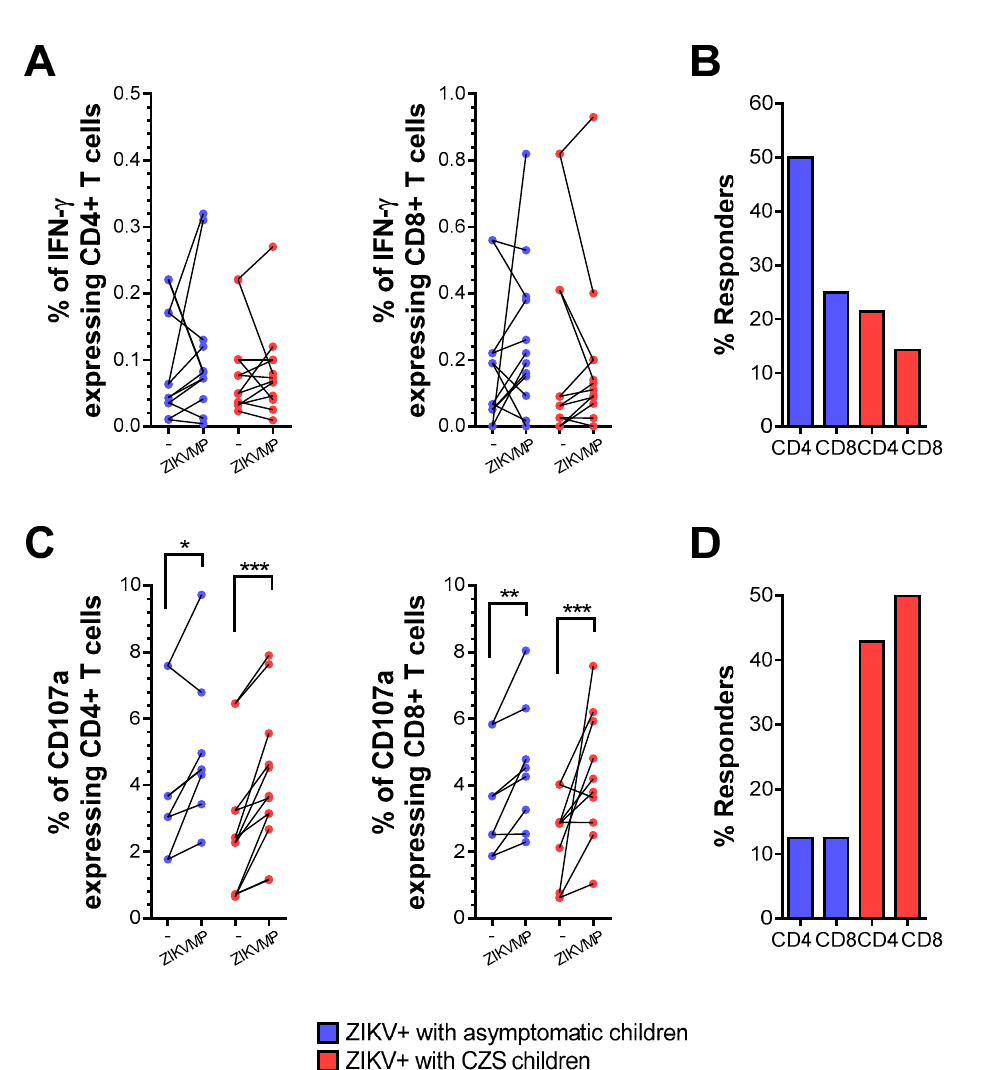
Figure 2. IFN- γ production and CD107a expression in T cells from mothers with a history of ZIKV infection. The ICS profiles of IFN- γ staining and CD107a expression in CD4 and CD8 T cells after stimulation with ZIKV MegaPool (MP) peptides are shown in a mother infected with ZIKV during pregnancy. Cells from mothers who had asymptomatic children (blue, n = 8–12) and among whom had children with CZS (red, n = 10). ( A ) Data are expressed as symbols and lines without ZIKV peptide stimulation (-) and after ZIKV peptide stimulation (ZIKV MPs), regarding the percentage of CD4+ and CD8+IFN- γ + cells. Statistical analyses were performed using the Wilcoxon matched-pairs signed-rank test between unstimulated (-) and ZIKV MPs stimulation in each group of mothers. ( B ) Responses were considered positive if the percentage of IFN- γ + cells with ZIKV MPs showed a stimulation index of ≥ 2 compared with the percentage of IFN- γ + cells without ZIKV MPs (-). Statistical significance for differences in frequency of responses was determined using Fisher’s test. ( C ) Data were shown in the same way as in ( D ), regarding the percentage of CD4+ and CD8+CD107a+ cells. Asterisks indicate significant differences (* p < 0.05, ** p < 0.01, *** p < 0.001).